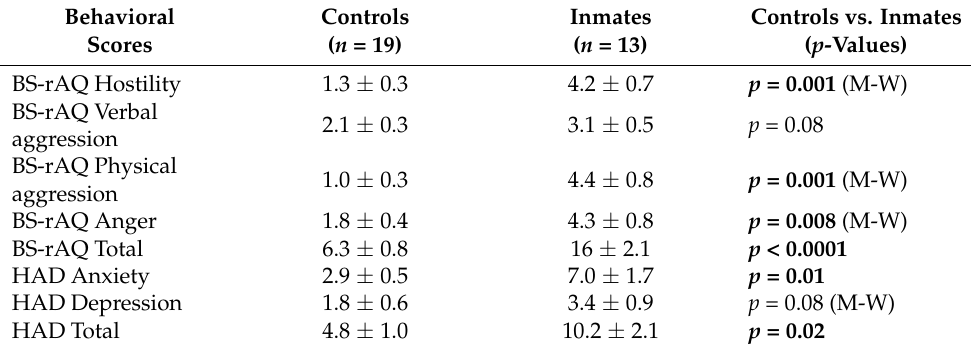
Table 1. Characteristics of aggressive behavior, mood and emotion in control and inmate groups as evaluated by the BS-rAQ and HAD scales. Values corresponding to each scale and subscale scores are shown as mean ± SEM. Group differences were compared using a two-tailed Students’ t -test or Mann–Whitney (M-W) test. Significant p -values are shown in bold. Behavioral Controls Inmates Controls vs. Inmates Scores ( n = 19) ( n = 13) ( p